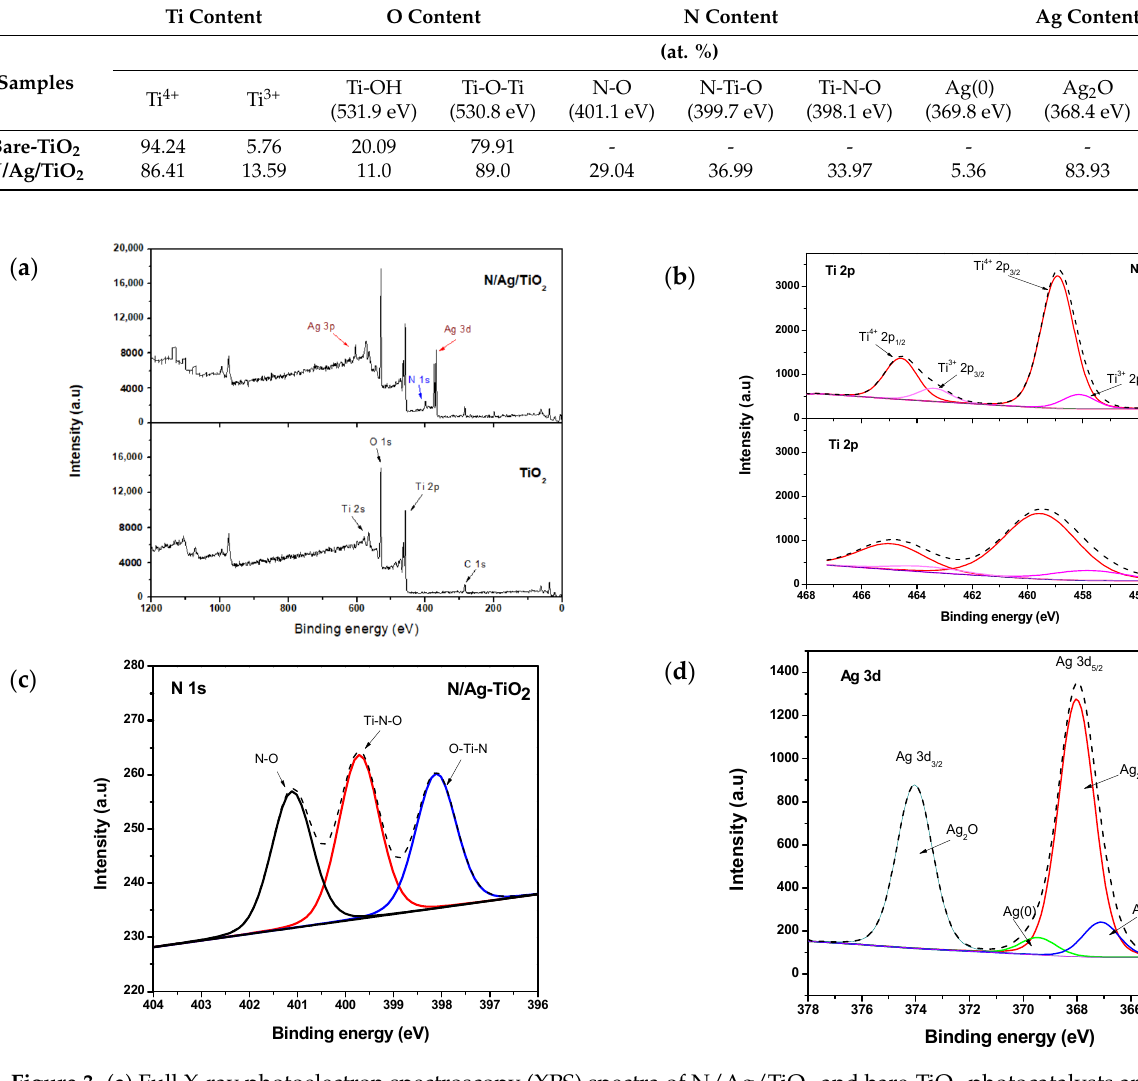
Figure 3. ( a ) Full X-ray photoelectron spectroscopy (XPS) spectra of N/Ag/TiO 2 and bare-TiO 2 photocatalysts and high-resolution spectra of ( b ) Ti 2p, ( c ) N 1s, and ( d ) Ag 3d. Table 3. Surface compositions (in at. %) of bare-TiO 2 and N/Ag/TiO 2 photocatalysts, obtained by XPS. Ti Content